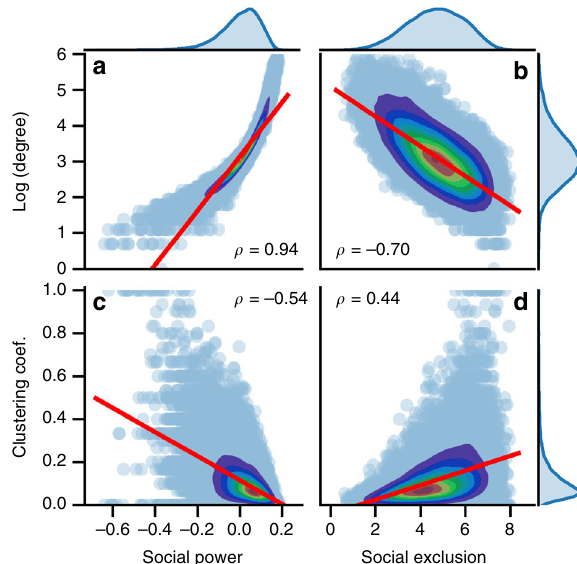
Fig. 3 Correlations between endowment-related variables and ego networks statistics for the Andorra dataset. a Social power versus degree. b Social exclusion versus degree. c Social power versus clustering coef fi cient. d Social exclusion versus clustering coef fi cient. Colors represent the density of data points, where red indicates dense areas and purple indicates sparse areas. All data points are plotted as light blue dots. ρ denotes Pearson correlation coef fi cients. All Pearson correlation coef fi cients are signi fi cant at level p <